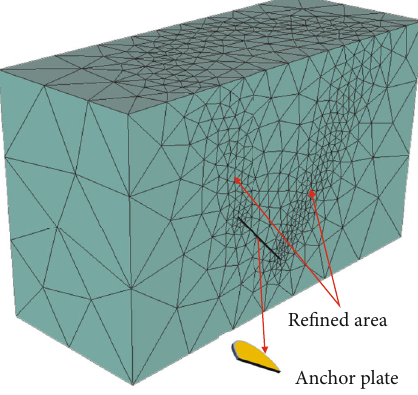
Figure 2: Mesh details of